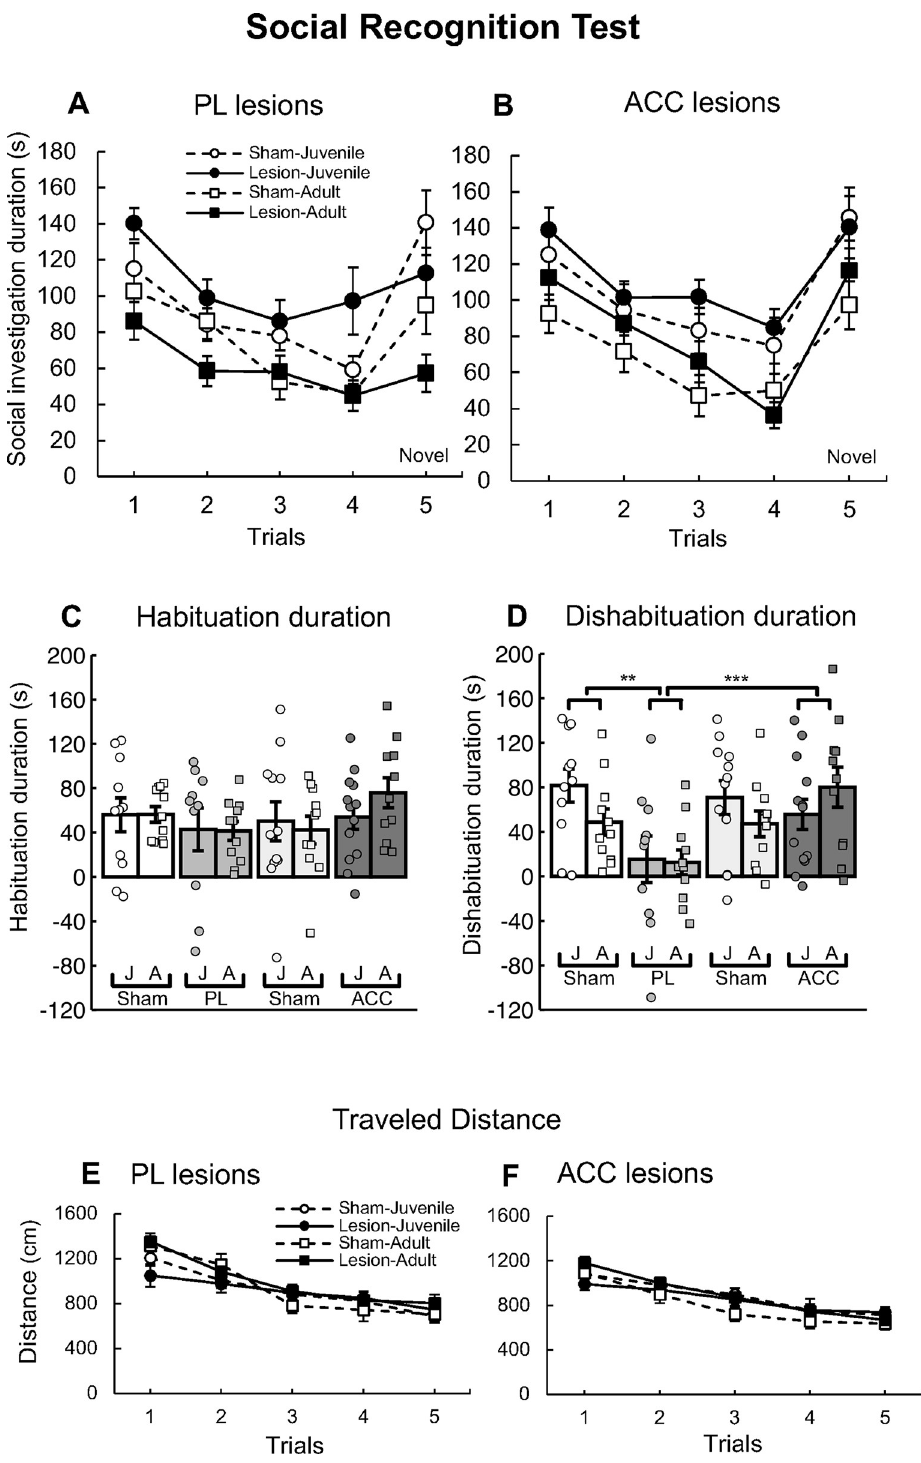
Fig 2. Results of the social recognition test (SRT) in the prelimbic cortex (PL)-lesioned and anterior cingulate cortex (ACC)-lesioned mice. (A) The mean social investigation (SI) duration in the PL lesion group-juvenile (•; n = 10), sham control group-juvenile ( � ; n = 11), PL lesion group-adult ( ■ ; n = 11), and sham control group-adult ( □ ; n = 11). (B) The mean SI duration in the ACC lesion group-juvenile (•; n = 13), sham control group-juvenile ( � ; n = 12), ACC lesion group-adult ( ■ ; n = 11), and sham control group-adult ( □ ; n = 11). The error bars indicate